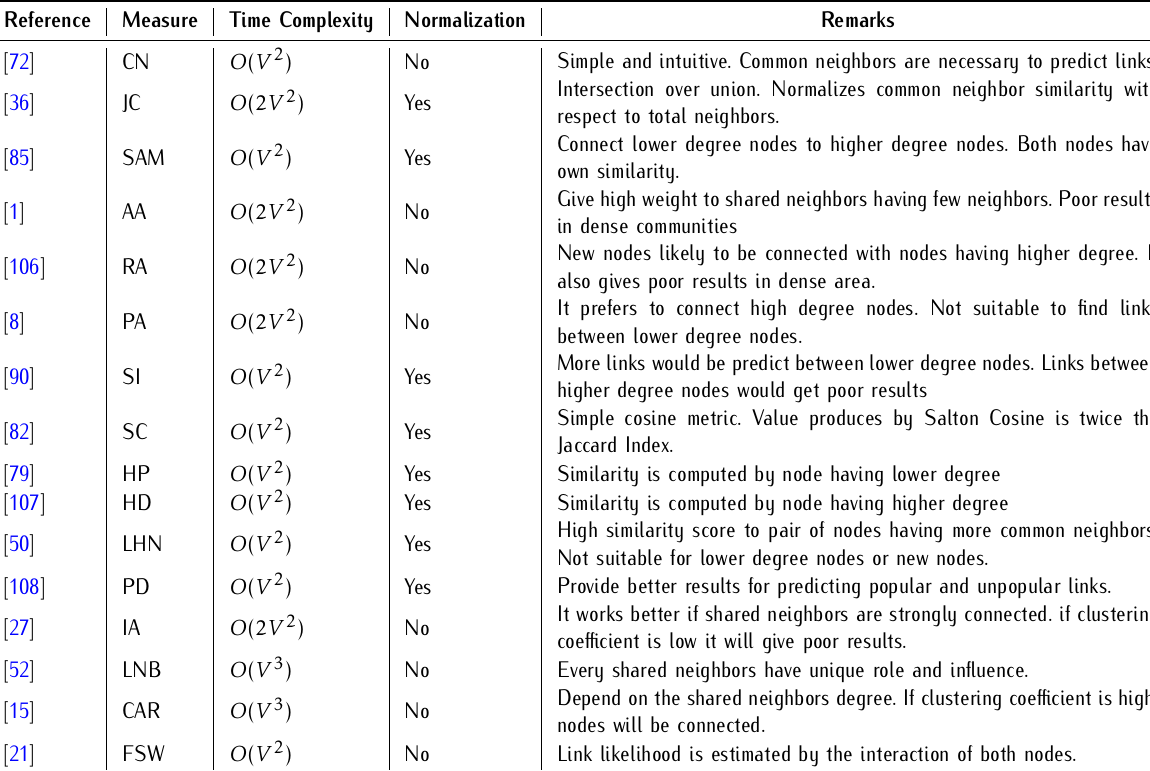
Table 1. Comparisons of Local Similarity